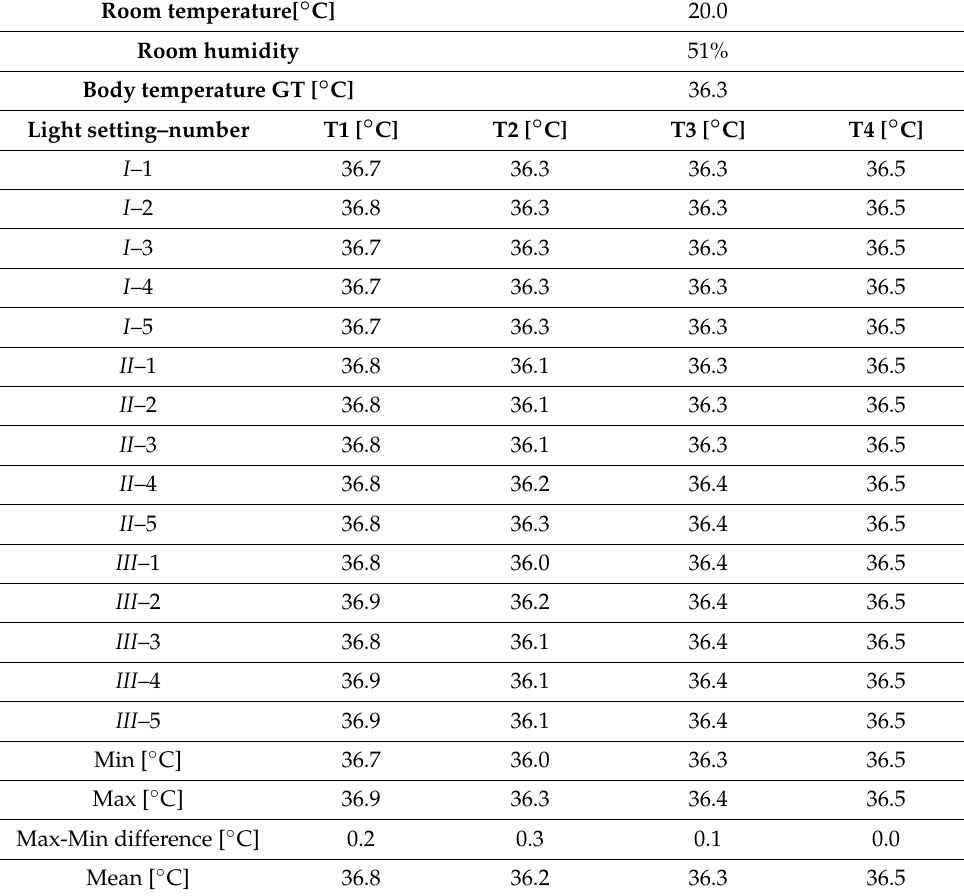
Table A12. Light influence experiment. Subject 3 body temperature